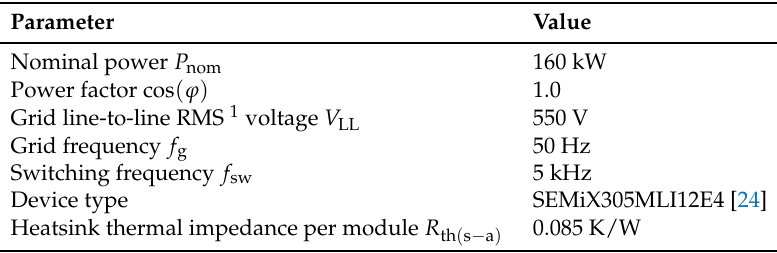
Table 1. PV System